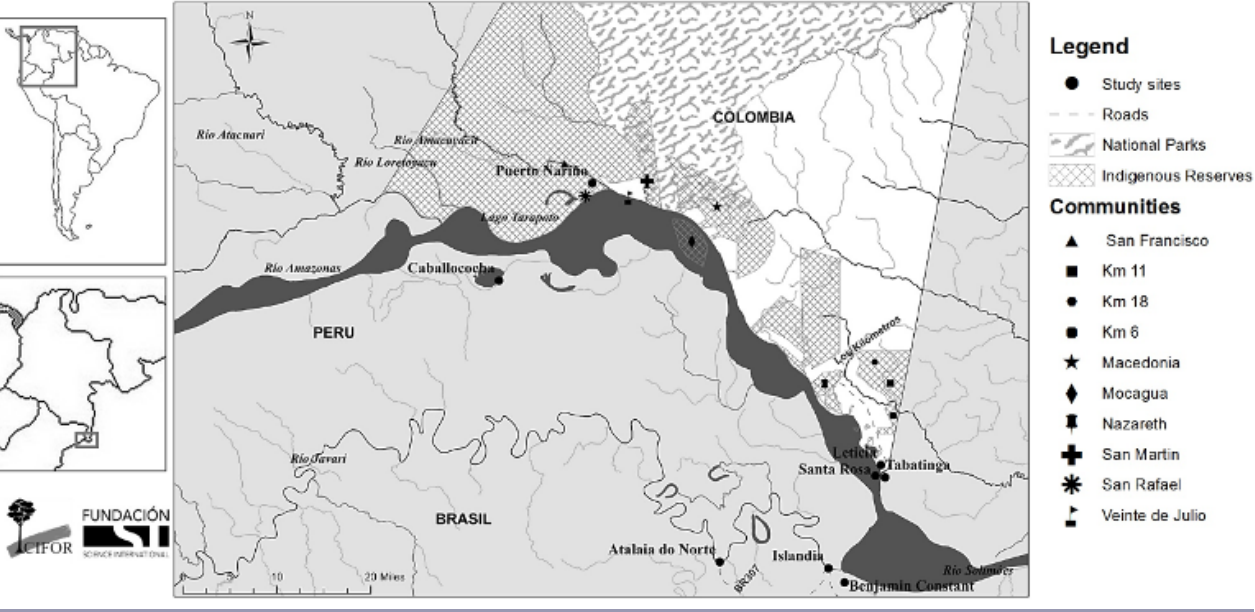
Fig. 1. Map showing the Tres Fronteras study area in the Amazon region of South